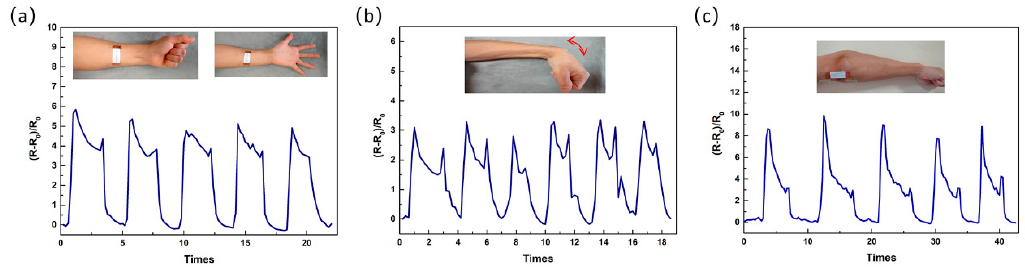
Figure 8. The monitoring of human motion using the ESD-ES strain sensors. The response to the motions of making a fist ( a ), wrist bending ( b ), and elbow bending ( c ).